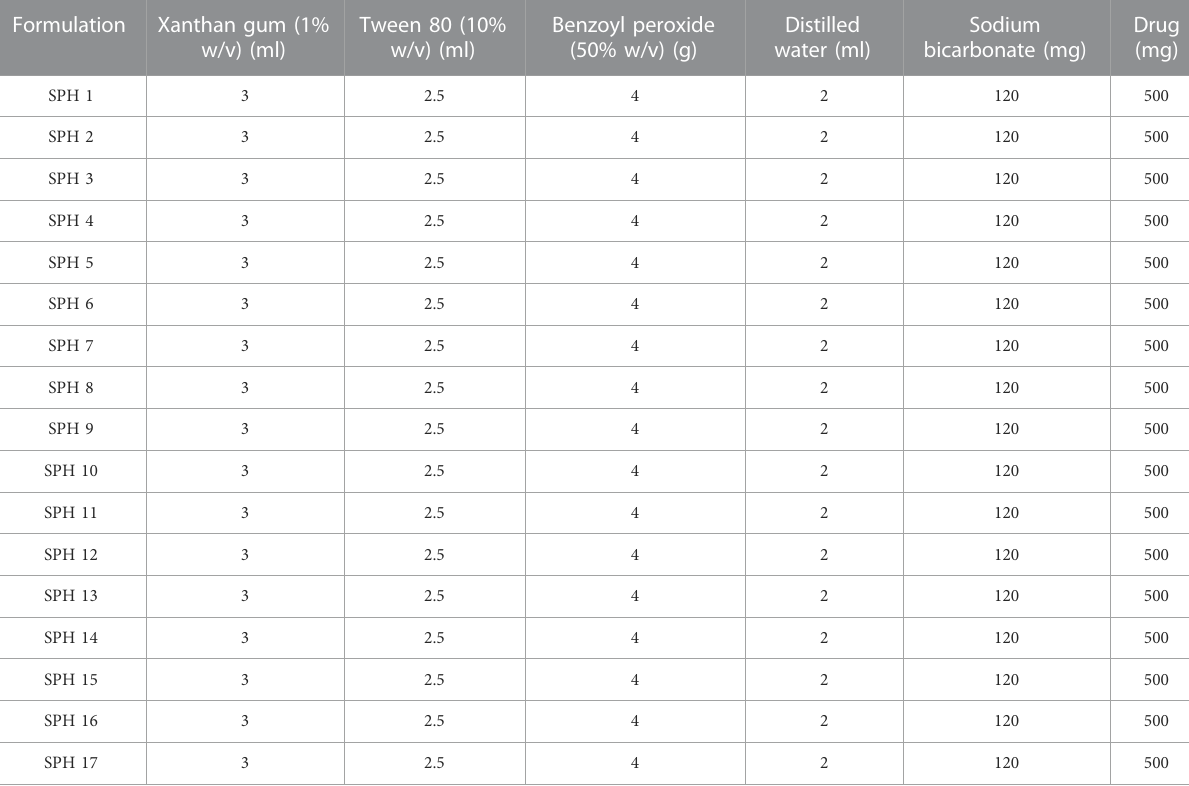
TABLE 2 Composition of ingredients of central composite batches.